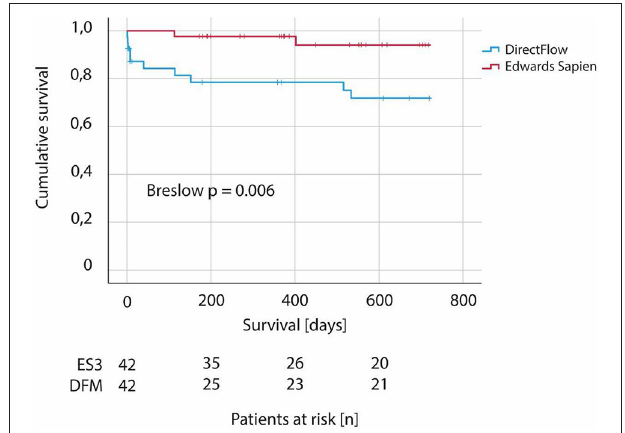
FIGURE 3 | Two-year MACE in patients undergoing TAVI—comparison between DirectFlow and Edwards Sapien 3. MACE defined as composite of all-cause death, stroke, and re-do-procedure (valve-in-valve) within 2 years from implantation of first valve (DirectFlow vs. Edwars Sapien 3). N =